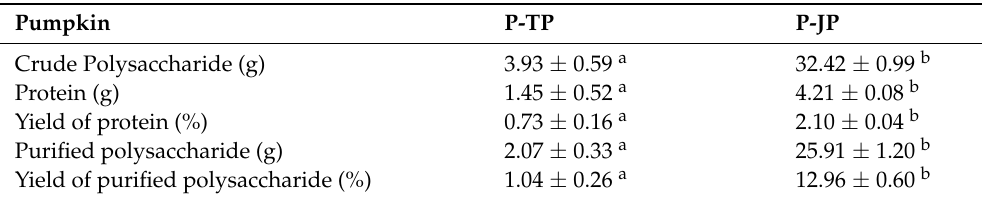
Table 3. Comparison of extraction and deproteinization of pumpkin polysaccharides. Pumpkin P-TP P-JP Crude Polysaccharide